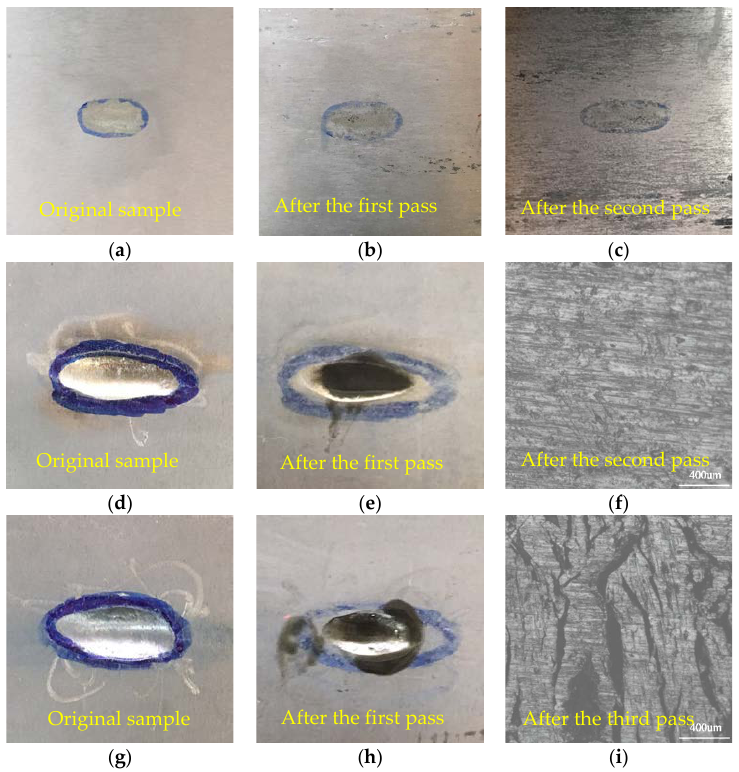
Figure 11. Contrasts in results of cold-rolling tests for strips with grinding depths of ( a – c ) 0.25 mm, ( d – f ) 1.5 mm, and ( g – i ) 2 mm.